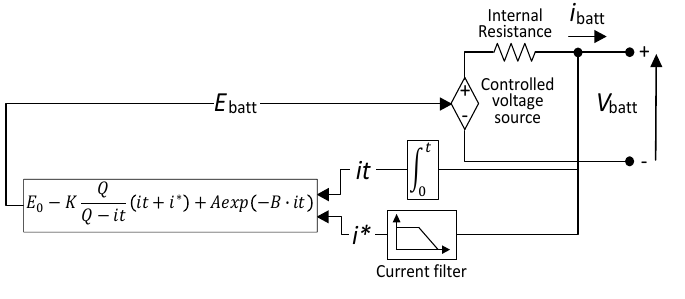
Figure 8. Discharge battery